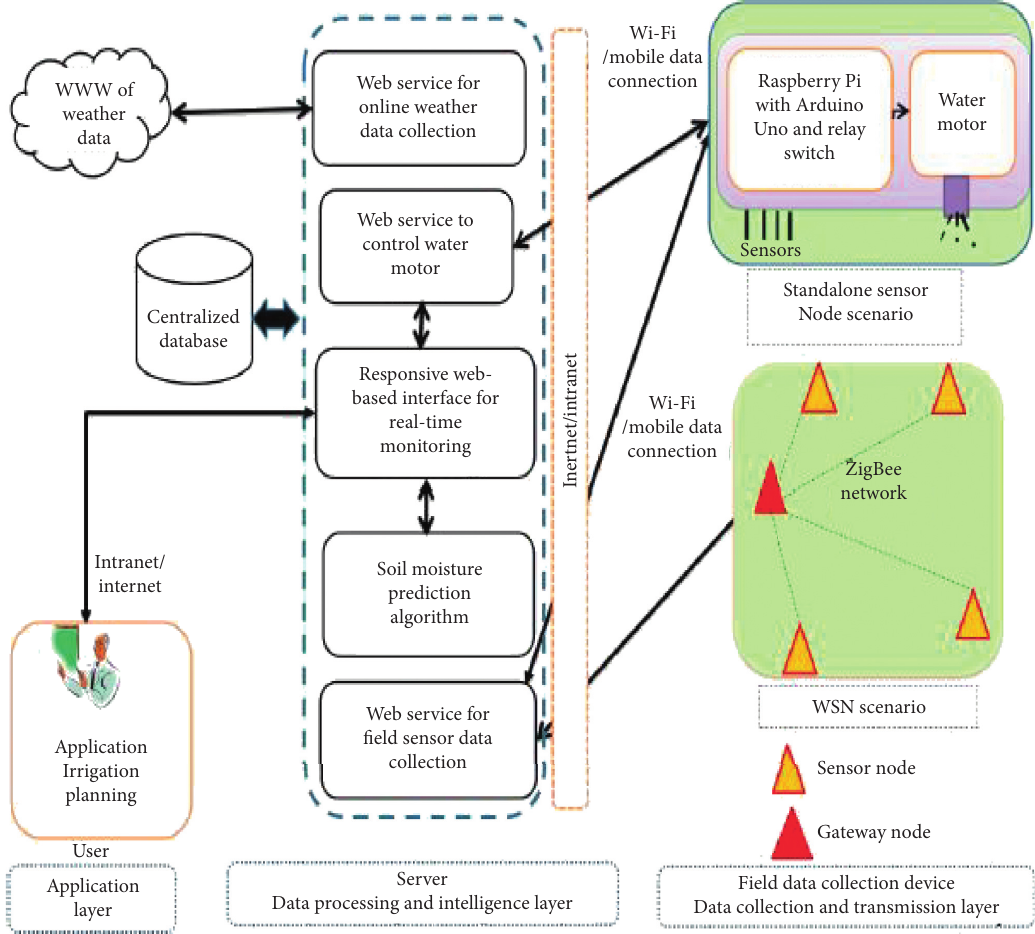
Figure 2: The architecture of the proposed